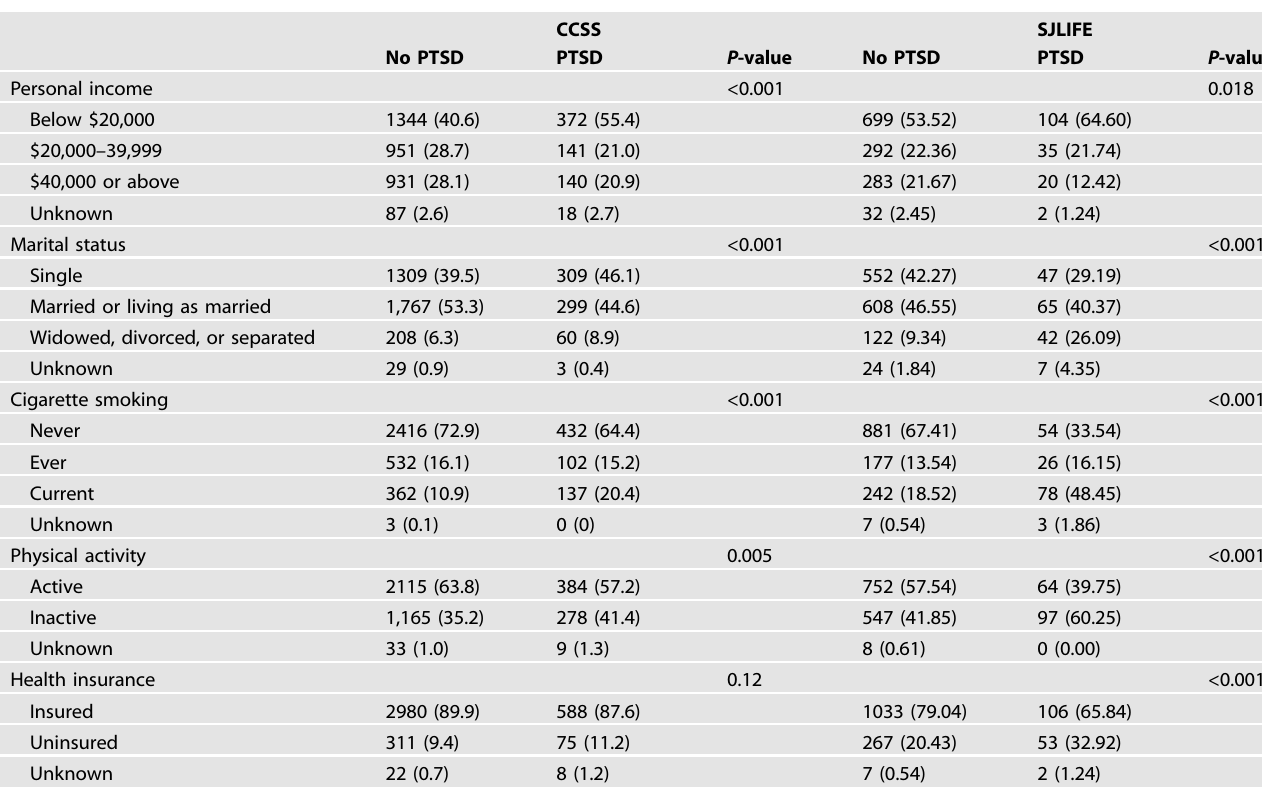
P -value< 5 × 10 – 8 , the most widely used threshold for common-variants GWAS [34], in the CCSS cohort or in meta-analysis were considered genome-wide signi fi cant. To illustrate robustness of fi ndings, associations of identi fi ed variants were examined by restricting PTSD cases to those with functional impairment or signi fi cant distress, respectively. To shed light on the speci fi city to PTSD, the associations of these variants were assessed by limiting to PTSD cases without clinically signi fi cant depression or anxiety, de fi ned as a t -score ≥ 63 on BSI-18 Depression or Anxiety factors, respectively [35]. In addition, these variants were analyzed for the associations with overall and PTSD symptom subscores (i.e., re-experien- cing, avoidance, and arousal symptoms) using linear regression. Genetic markers were mapped using FUMA (Supplementary Methods) [36], followed by pathway analysis was performed using MAGMA